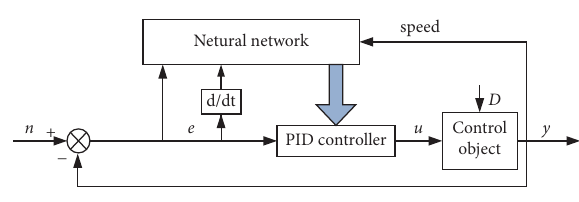
Figure 3: Principle of the NN-PID